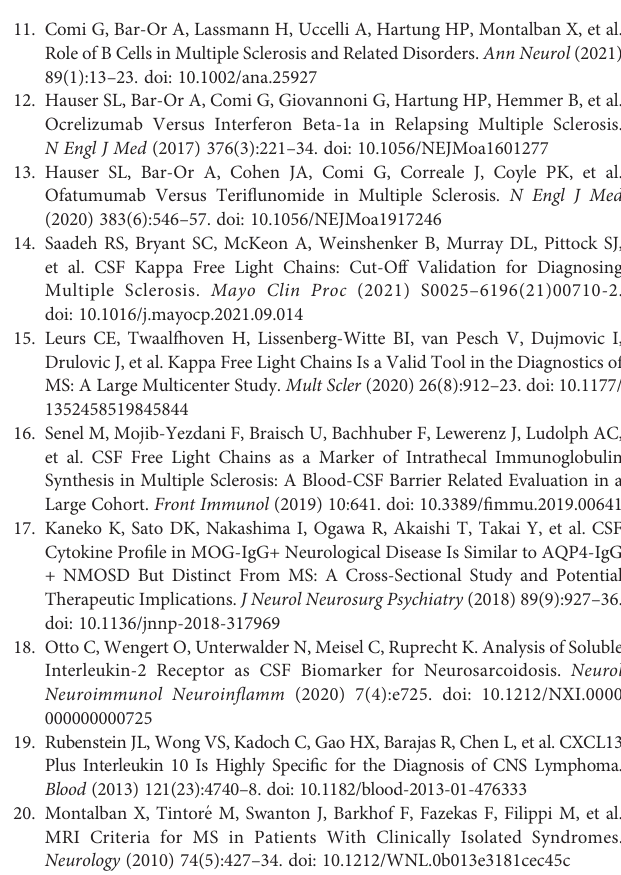
Supplementary Figure 1 | Flow chart. CNS, central nervous system; MS, multiple sclerosis; MSARD, multiple sclerosis and related disorder; OIND, other in fl ammatory neurological disorder; WMH, white matter hyperintensities. Supplementary Figure 2 | Distribution of KFLC biomarkers into RIS, CIS, and MS subgroups. CIS, clinically isolated syndrome ( n =22); MS, multiple sclerosis ( n =58); RIS, radiologically isolated syndrome ( n =8); ns, non signi fi cant ***p < 0.001. Supplementary Figure 3 | Distribution of CSF CD25, IL6, and IL10 into RIS, CIS, and MS subgroups. CIS, clinically isolated syndrome ( n =22); MS, multiple sclerosis ( n =58); RIS, radiologically isolated syndrome ( n =8). ns, non signi fi cant *p < 0.05. Supplementary Figure 4 | ROC curves of KFLC index, KFLC IF, CSF CD25, IL6, and IL10.[( A ) ROC curve that separate MSARD from NIND ( n =141)]. Panel (B) ROC curve that separate MSARD from OIND ( n